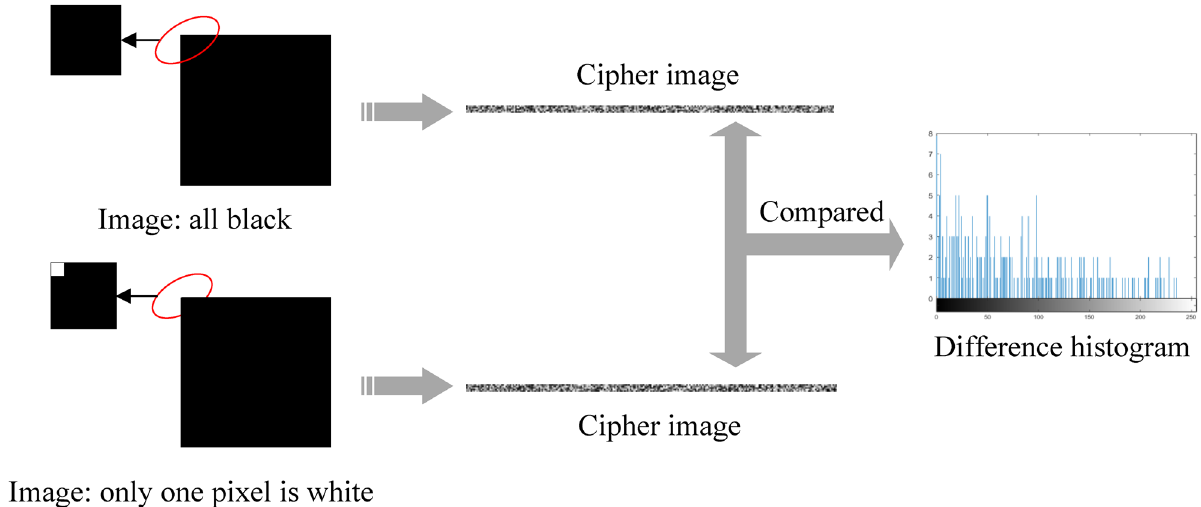
Figure 11. Plaintext sensitivity